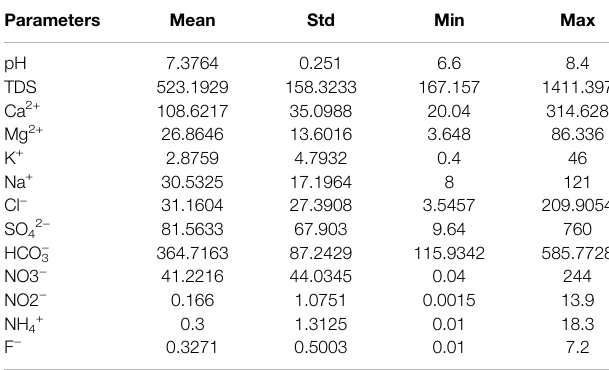
TABLE 1 | Statistical results of hydrochemical parameters (unit: mg/L, except for pH)